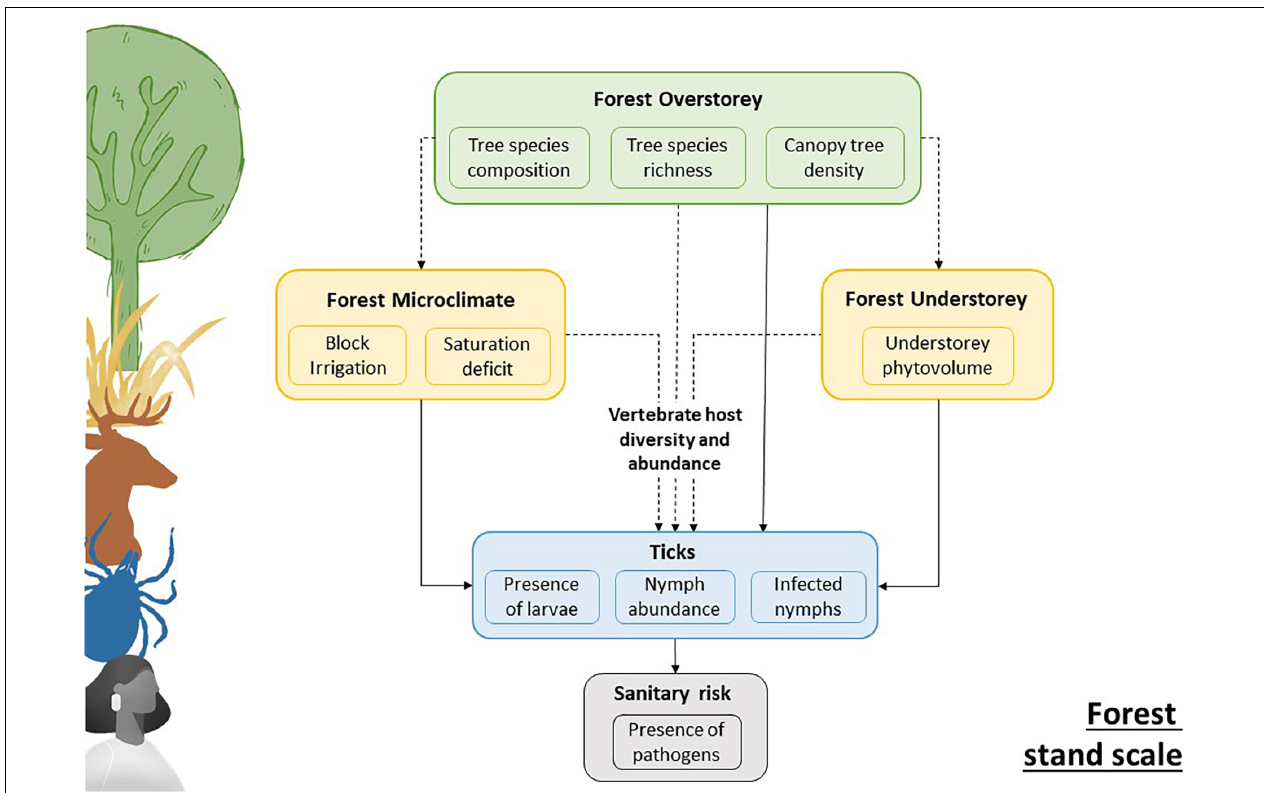
FIGURE 1 | Explanatory diagram showing our study hypotheses at the forest stand level. The biophysical and structural characteristics of the overstorey influence the ticks and associated pathogens through an influence on the within-stand microclimate, the understorey, and the host community in the environment. Diversifying host communities may result in a dilution of competent hosts in the environment and thus affects the prevalence of tick-borne diseases. Dashed arrows represent effects not tested in our